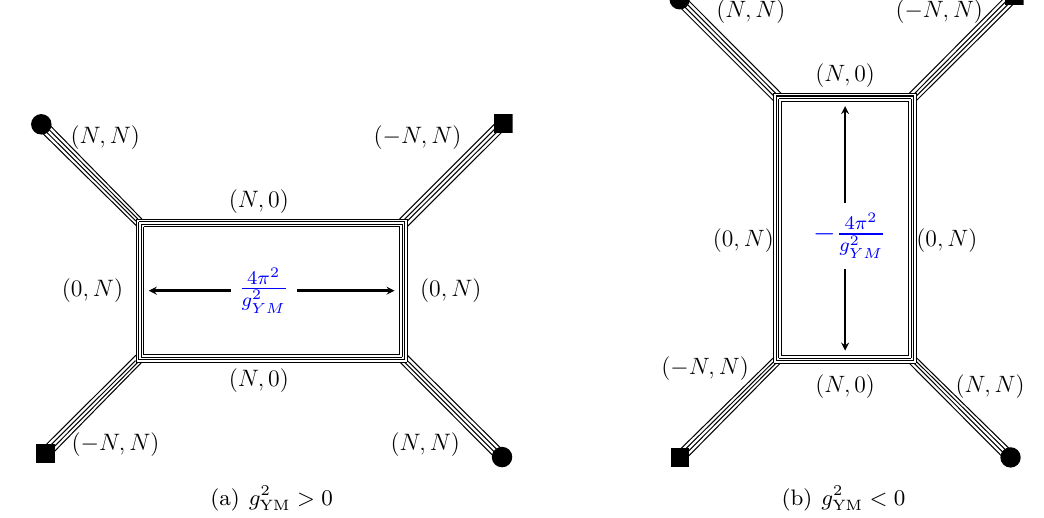
Figure 11 . ( p, q ) web for a USp(2 N ) gauge theory with a hypermultiplet in the antisymmetric representation at positive and negative